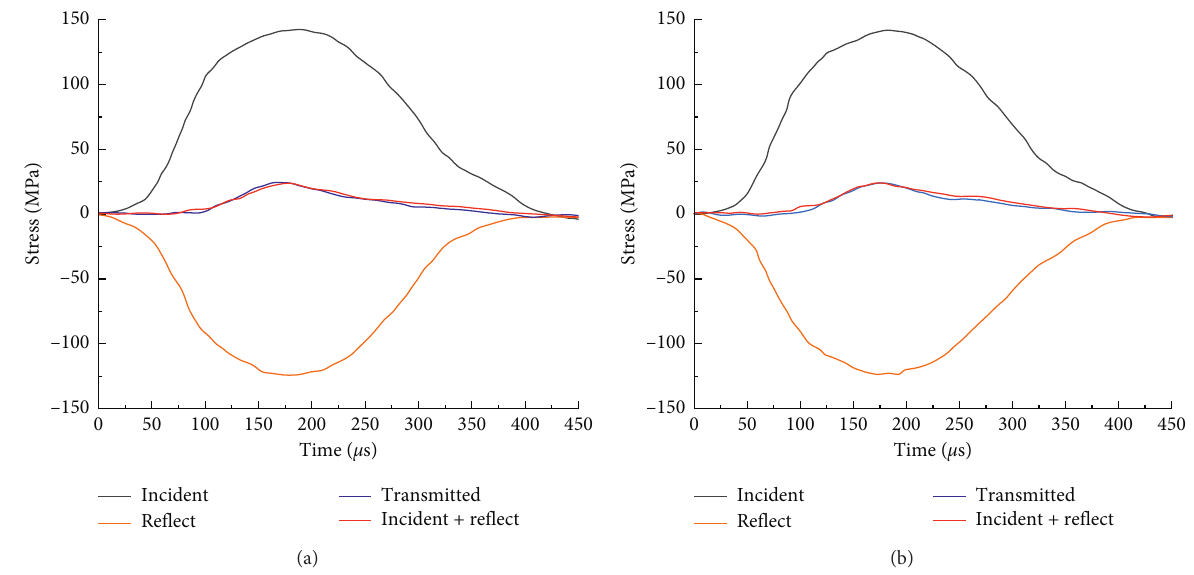
Figure 3: Typical dynamic stresses checked under uniaxial and coupled static and dynamic states. (a) Uniaxial state. (b) Coupled static and dynamic state.